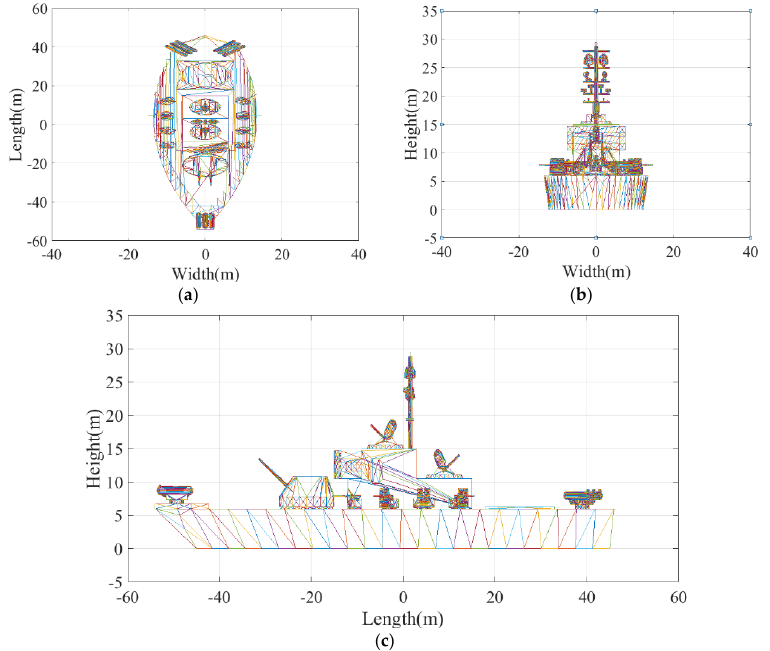
Figure 12. Three-dimensional tessellation ship target model. ( a ) Top view. ( b ) Front view. ( c ) Left view.